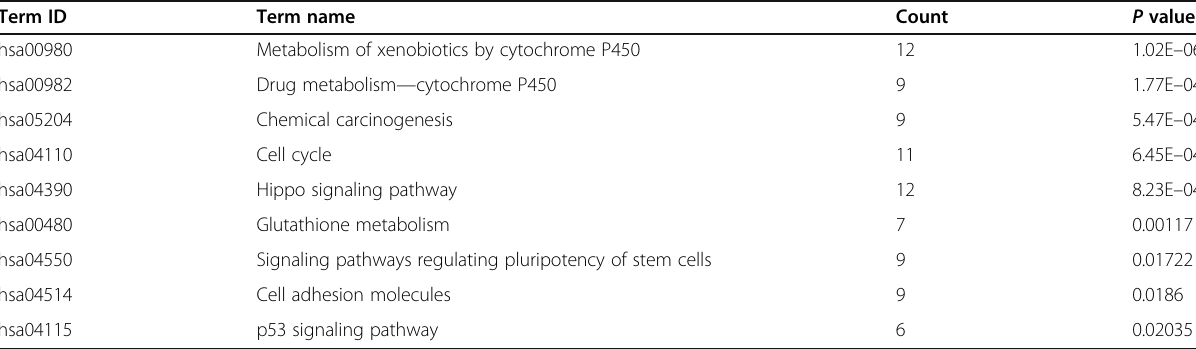
Table 3 The pathway analyses of upregulated genes Term ID